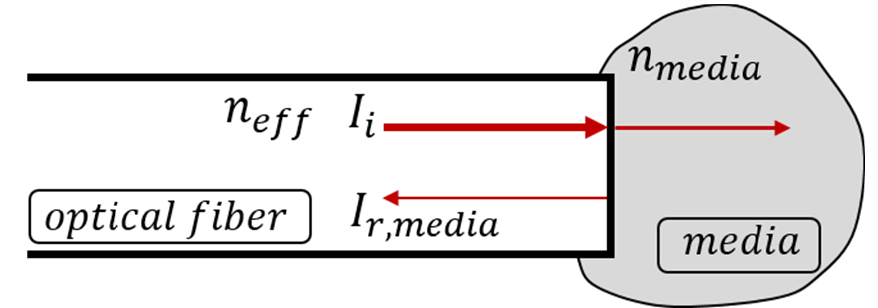
Figure 1. Simplified schematic representation of the Fresnel reflection of the optical fiber and media.